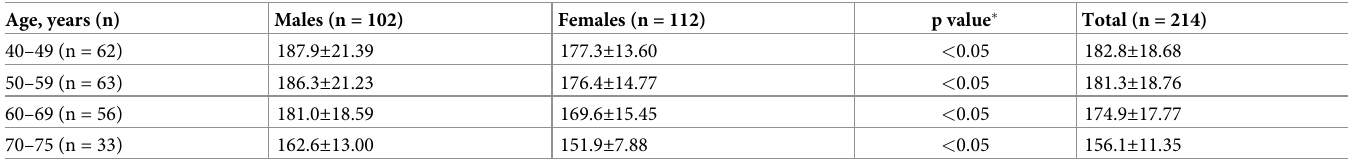
Values are expressed as the mean ± SD. � p value between males and females. 2MWD: Two-minute walk